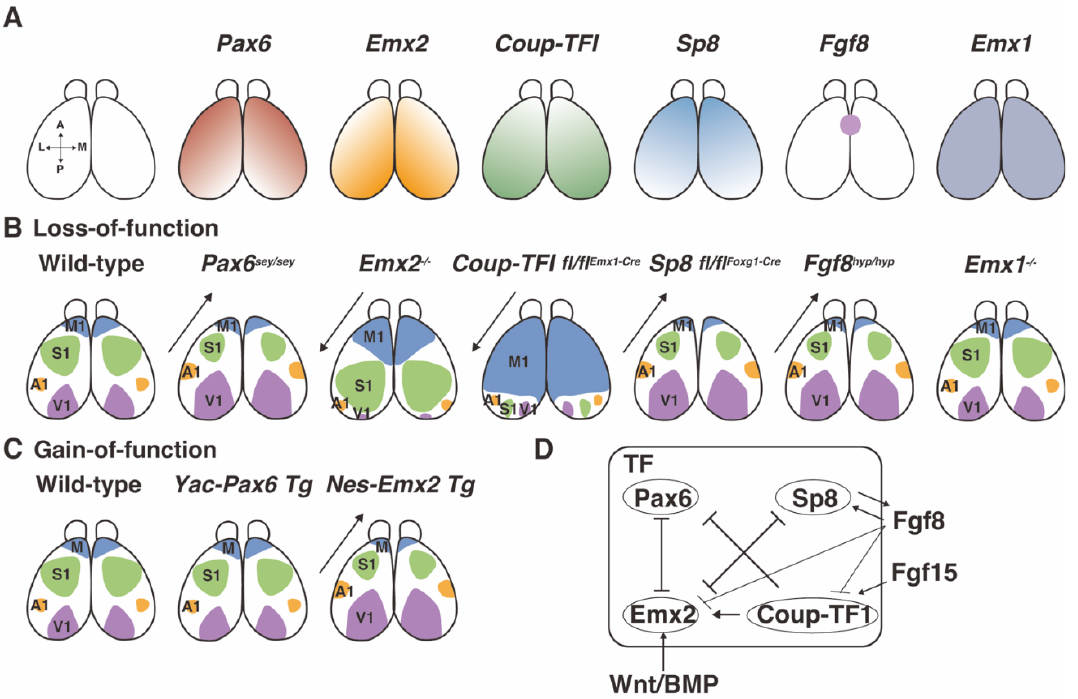
Figure 2. Gradient expression of key transcription factors in cortical patterning. ( A ) Gradient expression patterns of the major transcription factors Pax6, Emx2, Coup-TFI, Sp8, Fgf8, and Emx1 along the anteroposterior (AP) and lateromedial (LM); anterolateral (AL) and posteromedial (PM) axes. Pax6 is highly expressed along the AL axis, and weakly along the PM axis. Emx2 is expressed inversely to Pax6 . ( B , C ) Summary of loss-of-function ( B ) and gain-of-function ( C ) by the alteration of transcription factor expression in regard to cortical patterning. Analyses of brain formation indicate that Sey/Sey mice show a reduction in the M1 and S1 areas, as well as enlargement of the A1 and V1 areas. Embryonic analyses imply that Emx2 mutants show an inverse relationship to Sey/Sey mice. The overexpression of Emx2 under the control of a Nestin promoter increases the size of the V1 area. In contrast, the overexpression of Pax6 slightly reduces the size of the S1 area. ( D ) The regulatory network of transcription factors and secreted molecules. The BMP and Wnt gradients increase the expression of Emx2. Fgf15 enhances the expression of Coup-TF1. Fgf8 inhibits the ex-